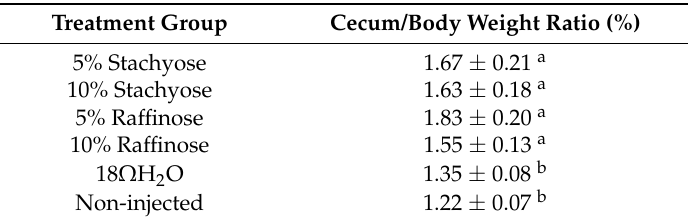
Table 1. Cecum-to-body weight ratio (%). Values are means ± SEM, n = 12. a,b Treatment groups not indicated by the same letter are significantly different ( p < 0.05).